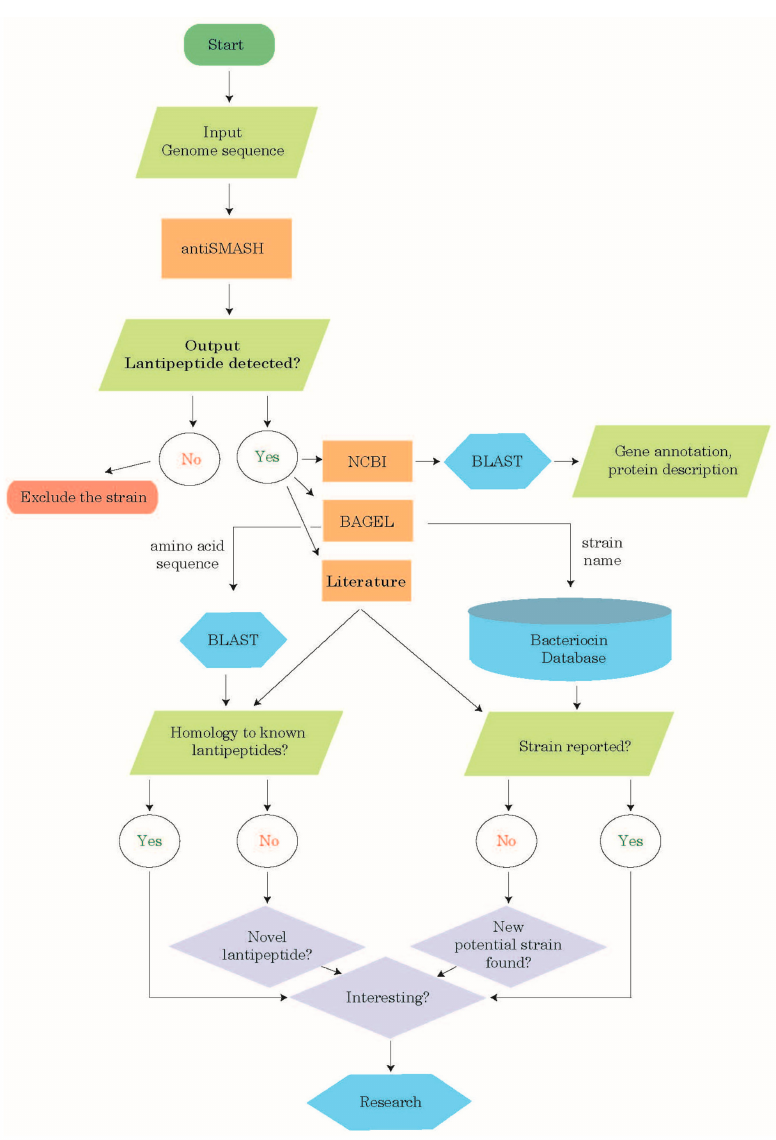
Figure 1. Workflow chart summarizing the analyses steps carried out in this